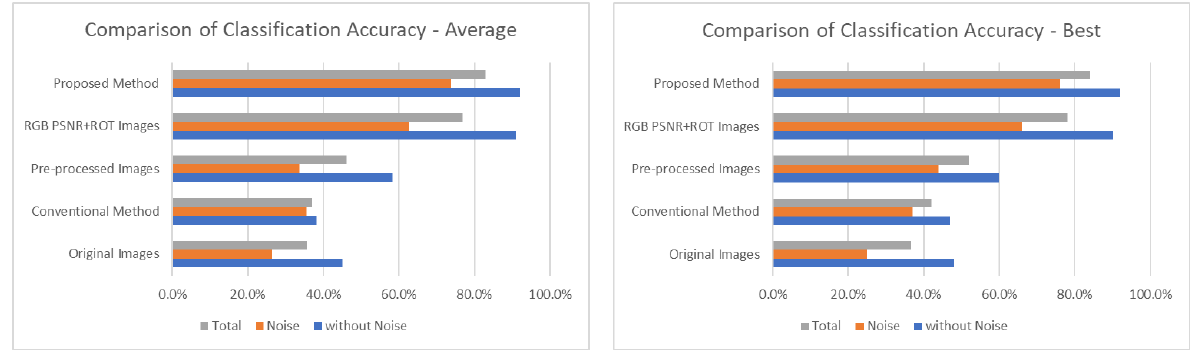
Figure 8. Comparison of classification accuracy.